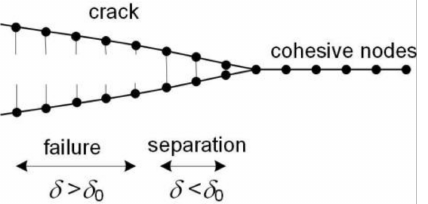
Figure 3. Application of cohesive zone to crack extension modeling. Other important parameters of the TSL are the maximum traction σ max (cohesive strength) and the corresponding separation ( δ c ). Regardless of the critical values of stresses and displacements, TSL dependence curves can take various forms, depending on the type of material (brittle or ductile) and separation mechanism. The integration of the TSL function allows the value of the dissipated energy to be determined for a specific increase in the crack length. The separation energy thus corresponds to the critical Griffith energy release rate. Traction–separation laws most often cited in the literature are presented in Figure 4.